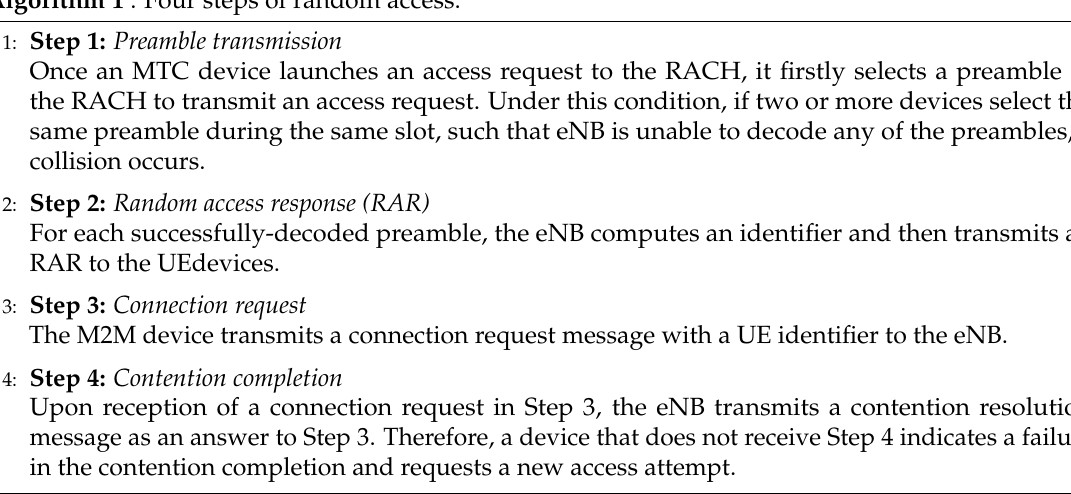
Algorithm 1 : Four steps of random